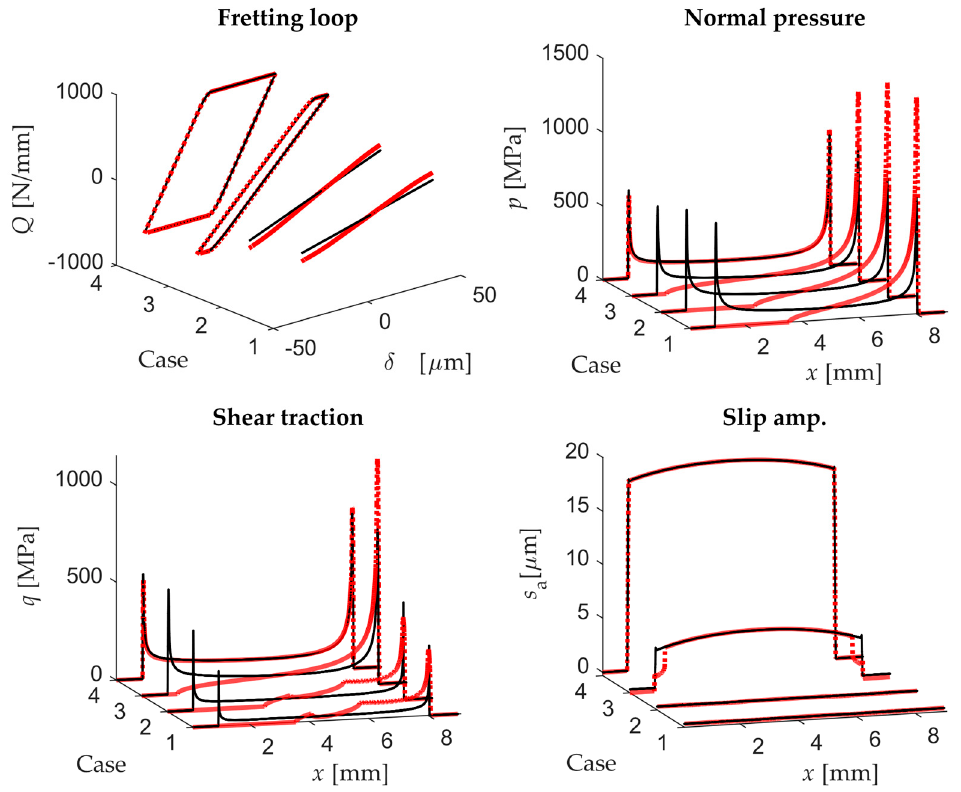
Figure 13. Fretting loops, normal and shear tractions at maximum displacement and slip amplitude along the contact for the four cases analysed with the 1st scenario (black continuous line) and 2nd scenario (red dotted line) using a flat-to-flat contact configuration .